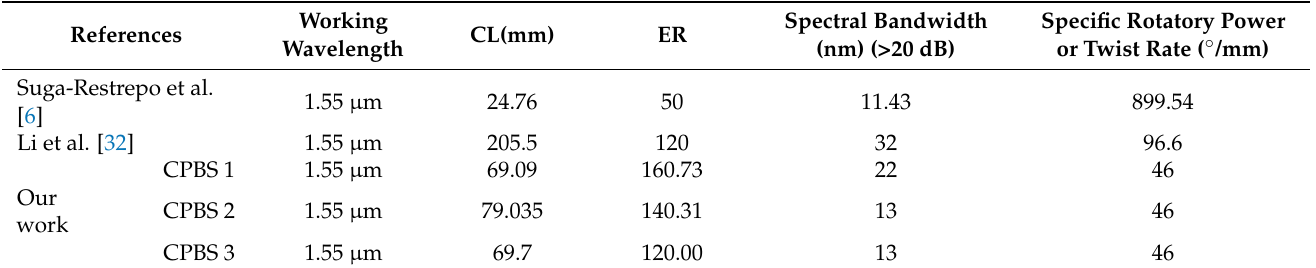
Table 1. Performance comparison between the proposed chiral DC-PCF CPBS and the reported chiral DC-PCF CPBS.